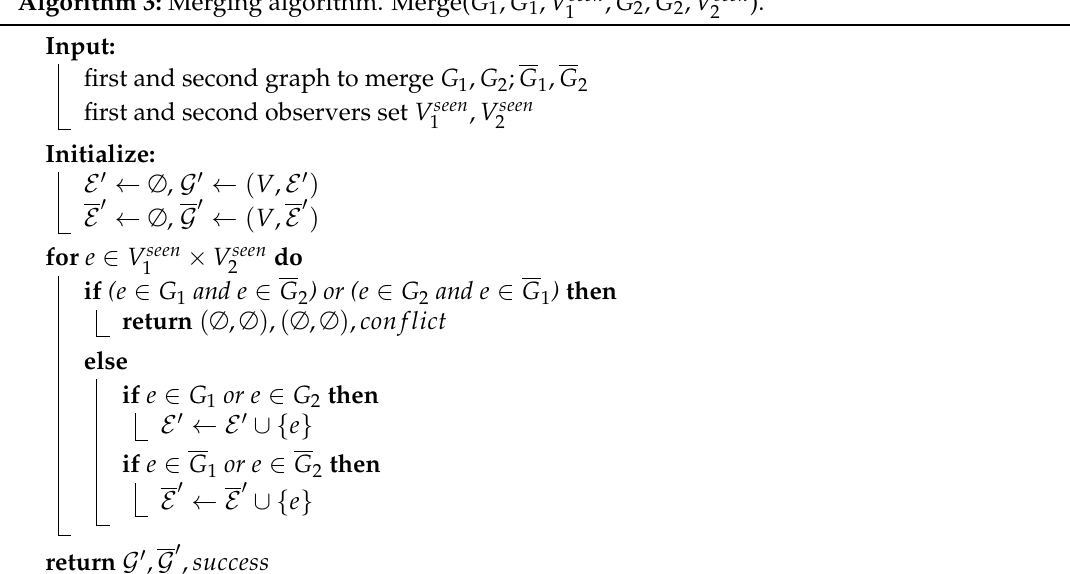
Algorithm 3: Merging algorithm. Merge( G 1 , G 1 , V seen